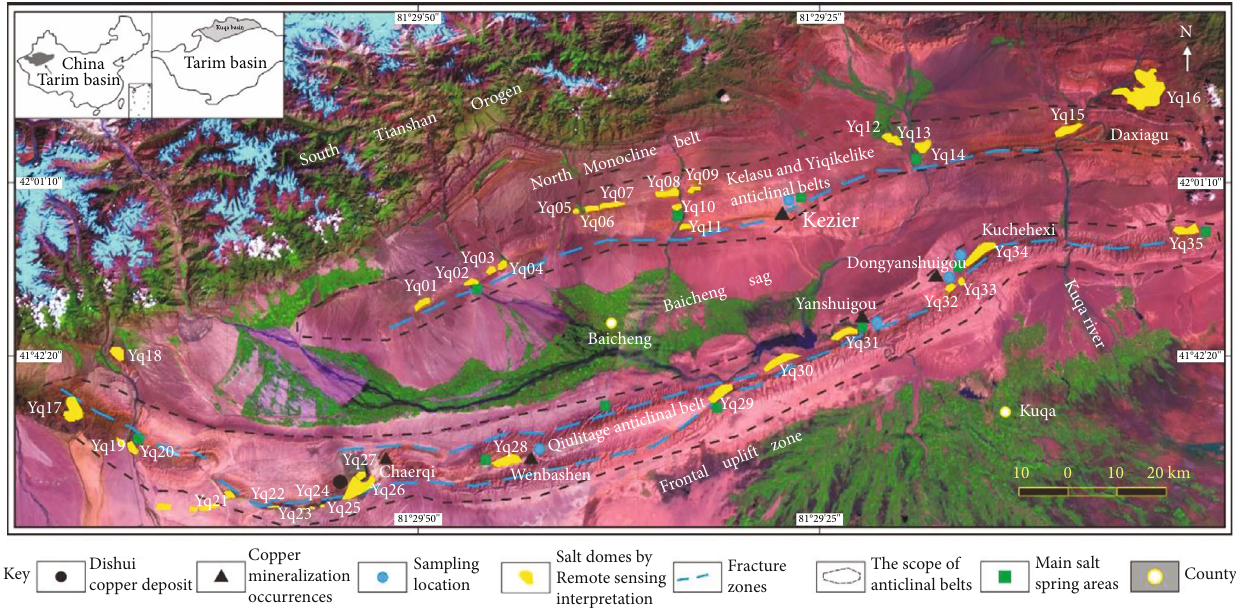
Figure 1: Schematic map of structure and sampling locations in Kuqa